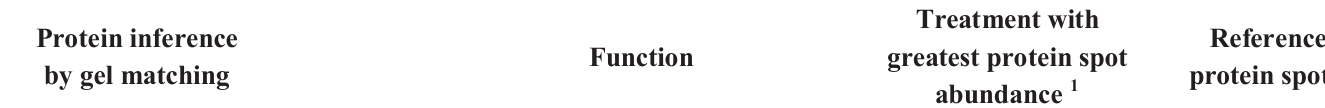
Table 4. Abundance of protein spots (inferred by gel matching) that was significantly affected by fertilization (including protein spots affected by PCM (A), PCM (but not fertilization (B), a fertilization × PCM interaction effect